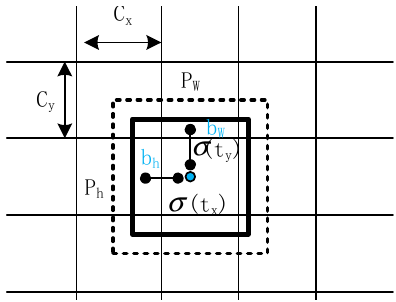
Figure 2. Schematic diagram of location prediction based on anchor.